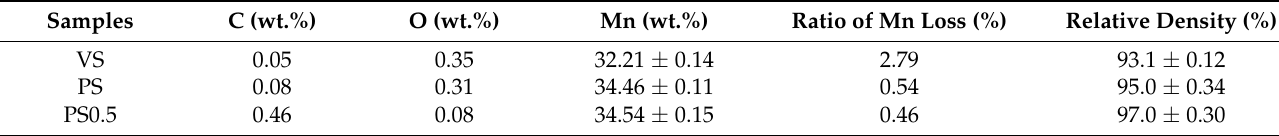
Table 2. The element content and relative density of the VS, PS, and PS0.5